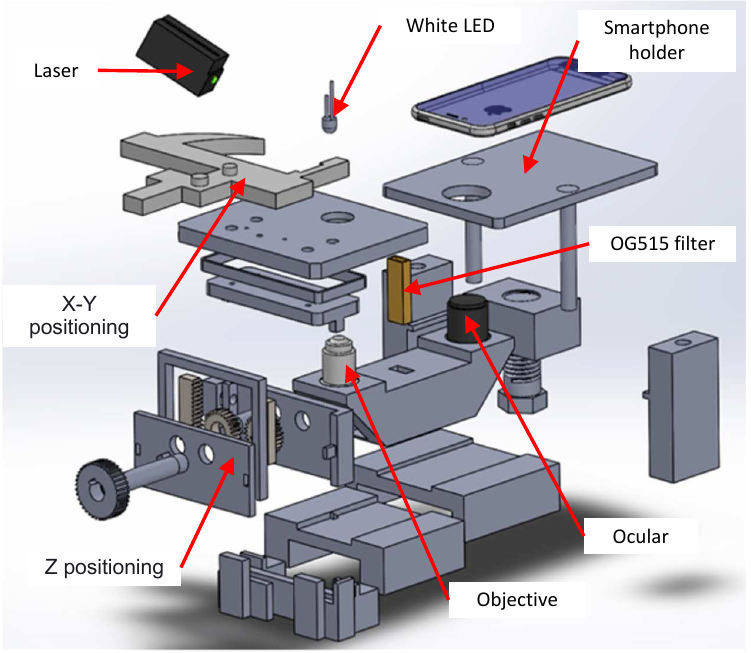
Figure 3. Block diagram of the 3D-printed laser fluorescence inverted